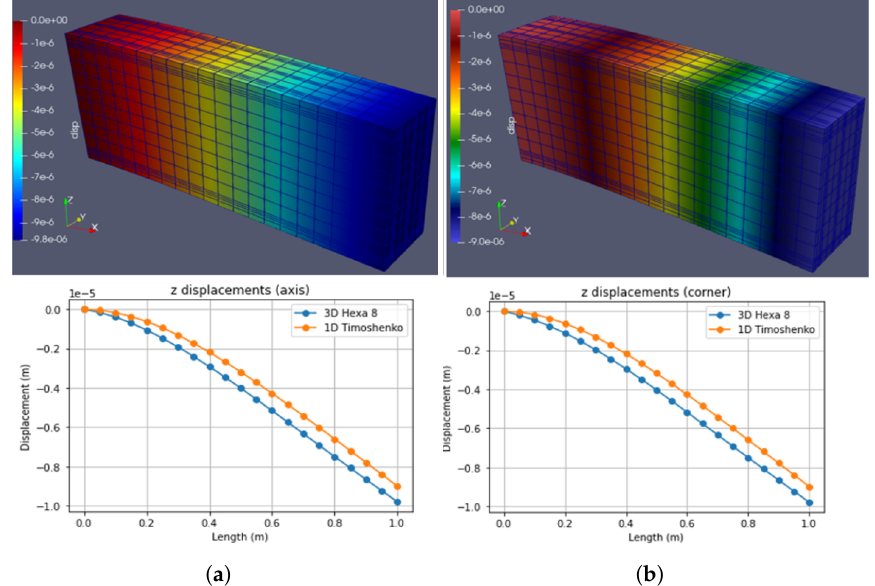
Figure 8. Case 1: Self weigth. ( a ) Hexa8. ( b ) Timoshenko. (Note: e − n indicates 10 − n ).